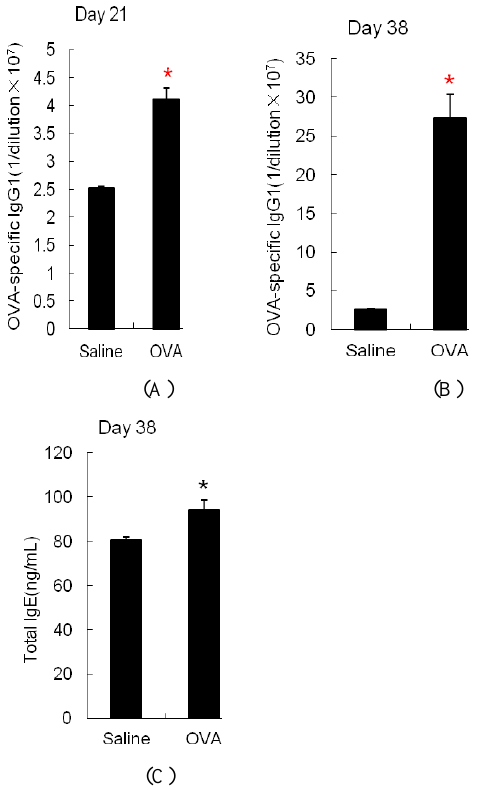
Figure 2. Serum OVA-specific IgG1 and total IgE levels. OVA- specific IgG1 were measured on d 21 (A) and d 38 (B), total IgE were determined on d 38 (C). (n = 12 mice/group; mean  SE; *